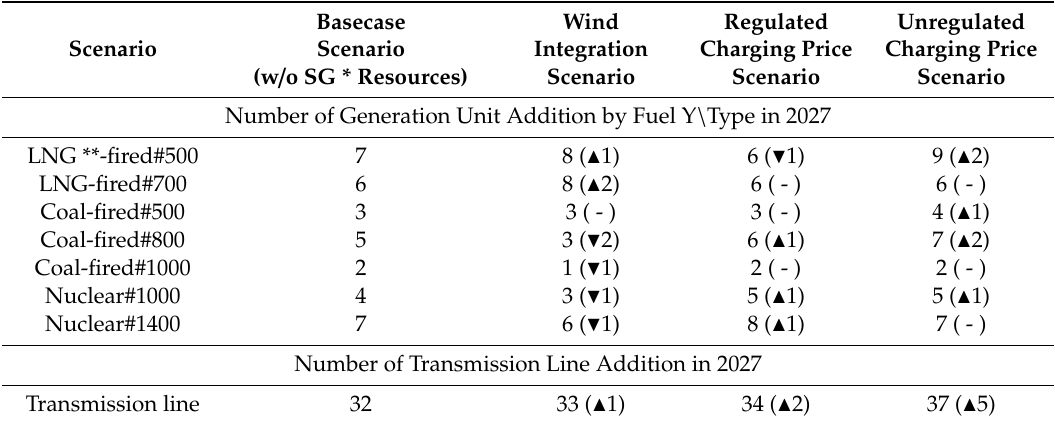
Table 4. Generation Unit and Transmission Line Addition by Smart Grid Deployment